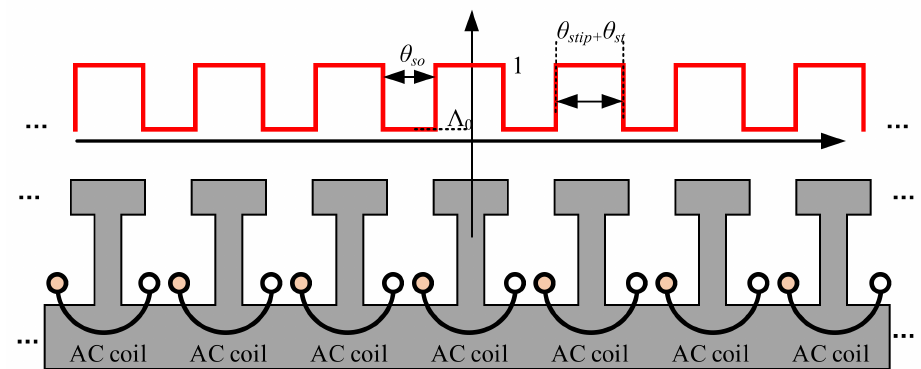
Figure 4. Stator relative permeance waveform of the WRSM.